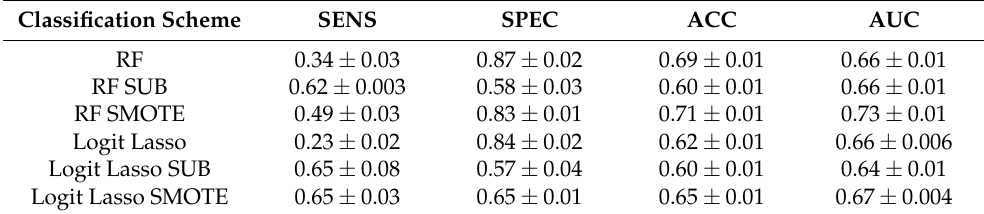
Table 3. Performance of the ML models for for the hold-out set (mean ± std). Classification Scheme